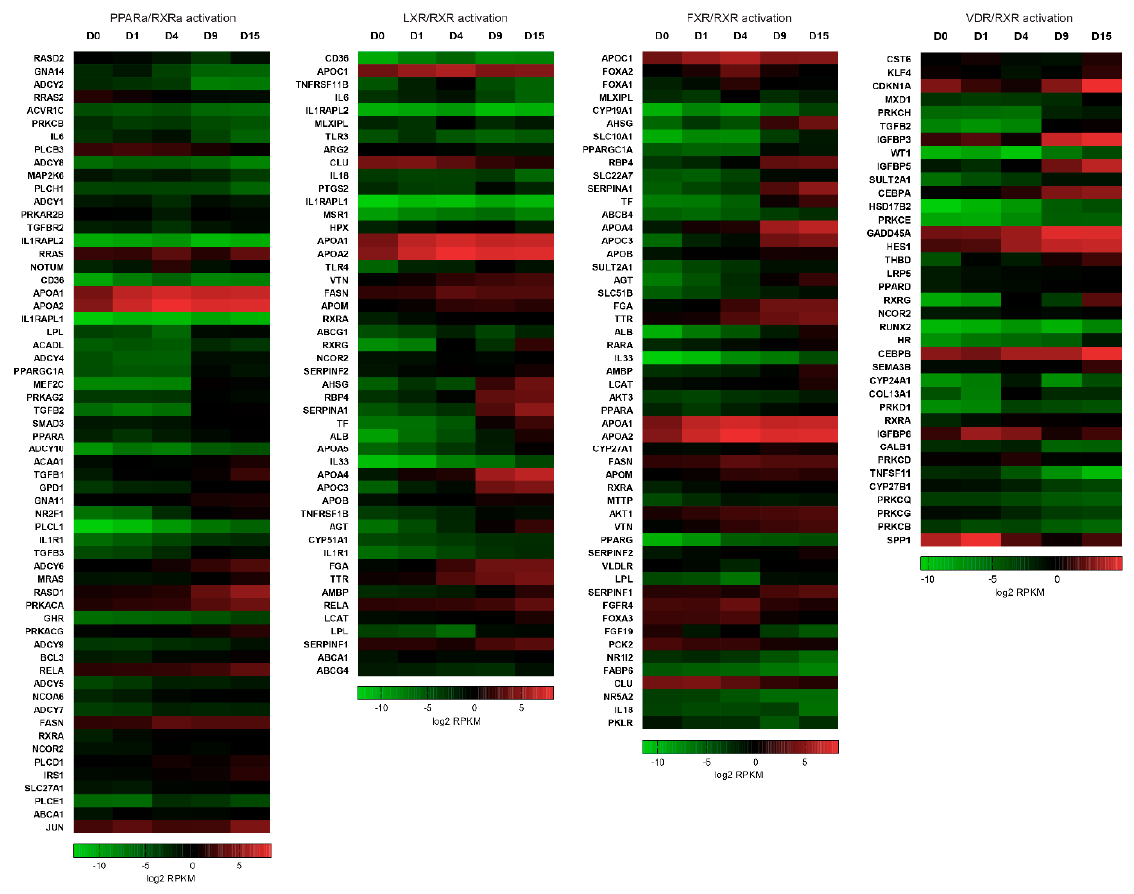
Figure 3. Retinoic X receptor (RXR) heterodimer pathways enriched in in vitro cardiac differentiation. Heatmaps repre- senting the gene expression profiles (log2 RPKM values) of DEGs related to the PPAR/RXR, LXR/RXR, FXR/RXR, and VDR/RXR activation pathways.